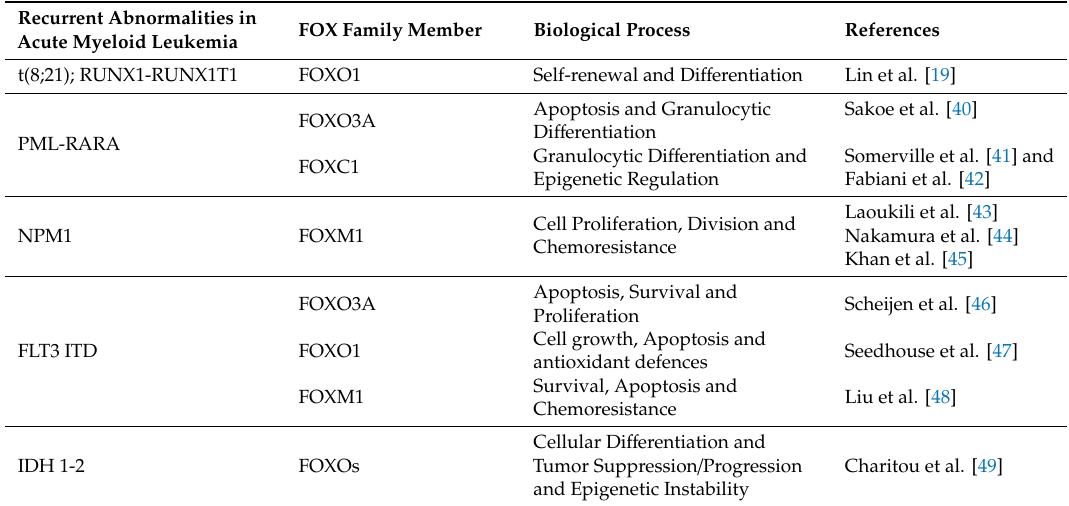
Table 1. Forkhead box factors deregulation according to acute myeloid leukemia (AML) recurrent abnormalities and their involvement in biological